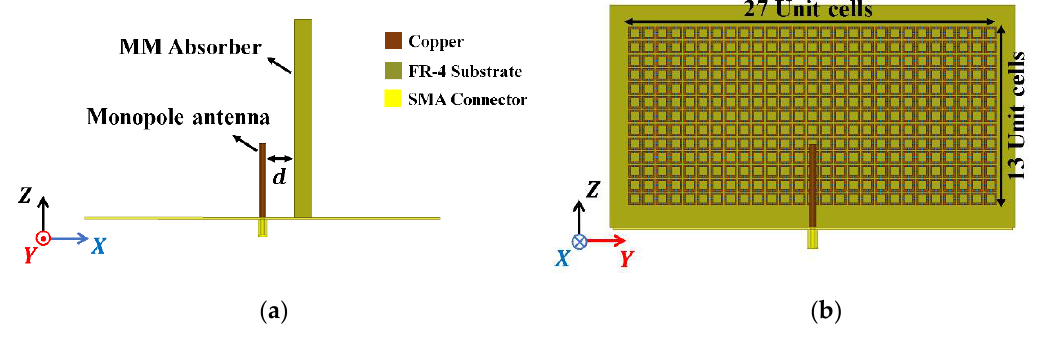
Figure 5. Proposed antenna: ( a ) side and ( b ) top view.